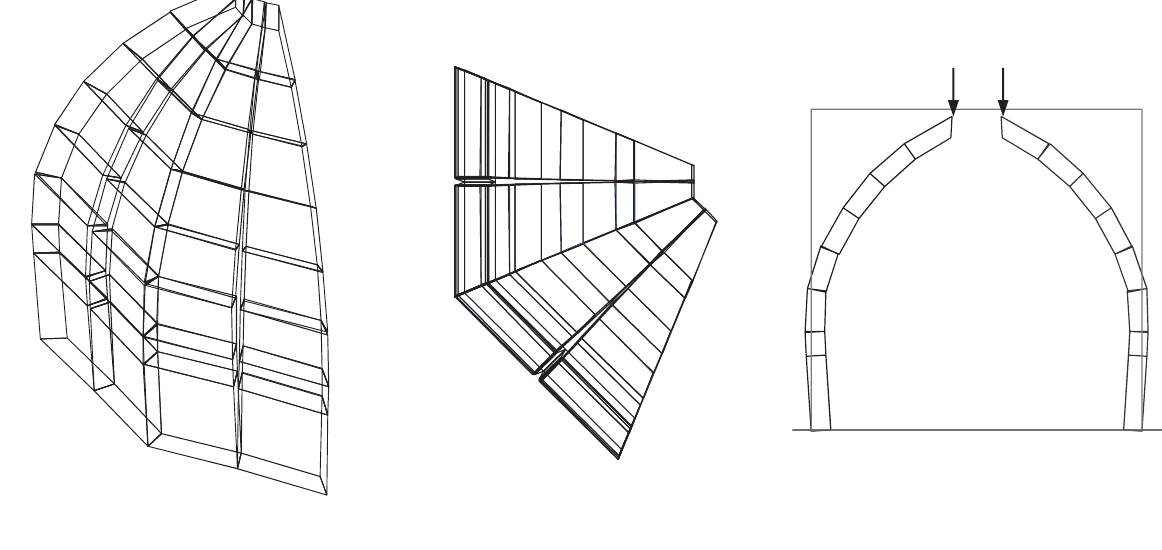
Feature (a): lack/presence of interlocking between the bricks at the